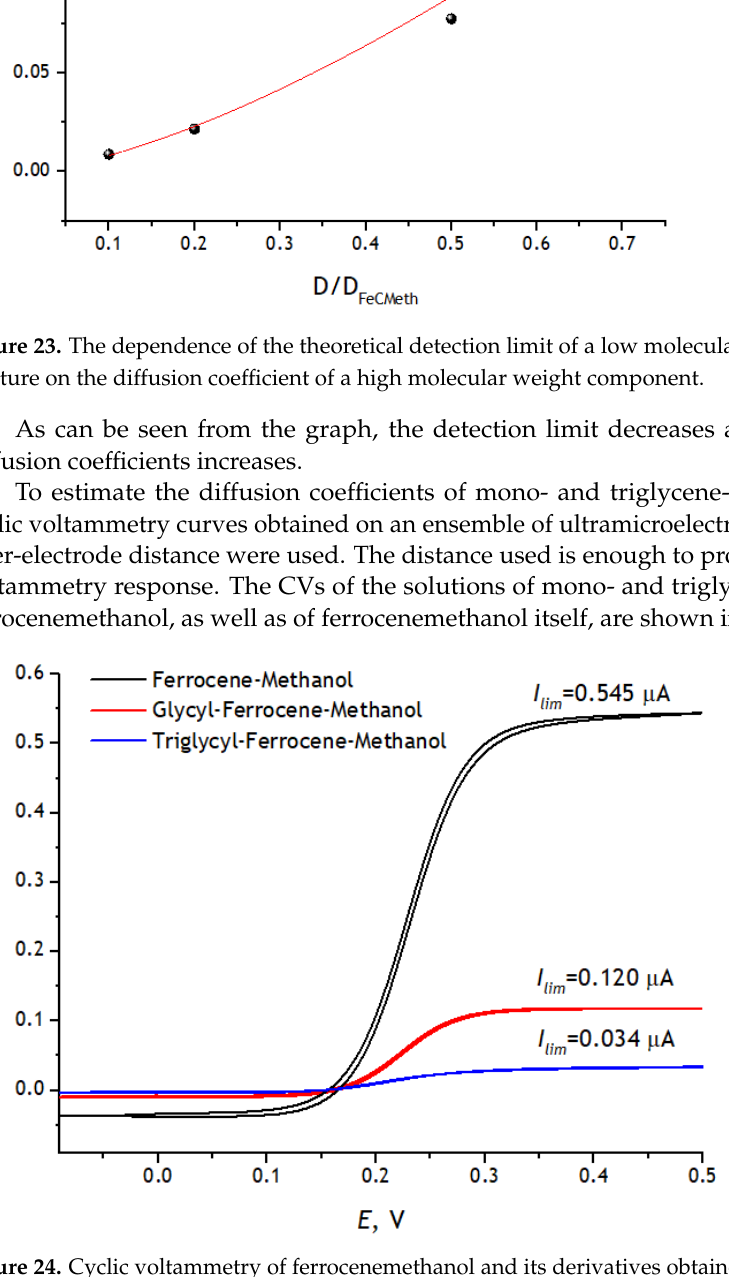
Figure 24. Cyclic voltammetry of ferrocenemethanol and its derivatives obtained with an ultramicroelectrode ensemble with inter-electrode distance 100 µm.